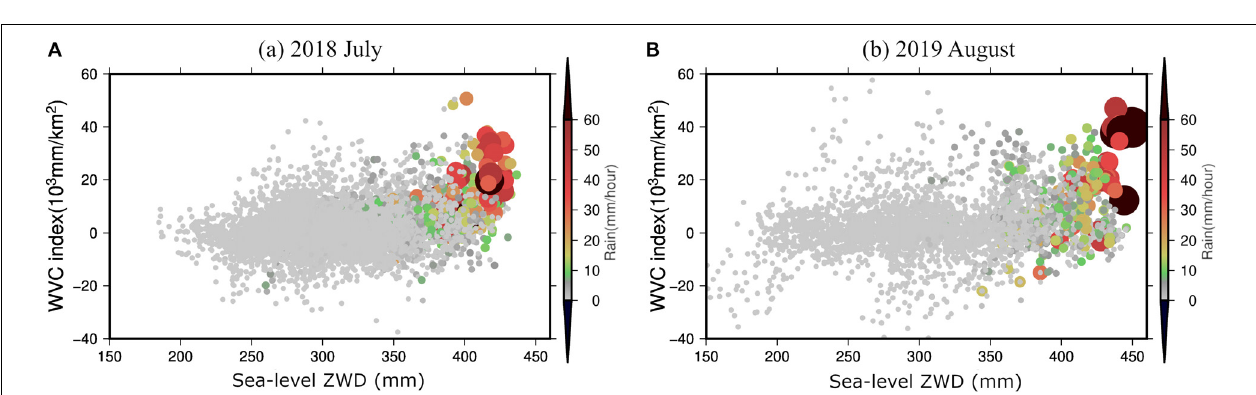
FIGURE 9 | Same as Figures 8B,C , but we stacked data for 12 and 5 AMEDAS stations showing hourly rain rate exceeding 50 mm in July 2018 (A) and August 2019 (B) , respectively. Again, we compare hourly rain rates with the WVC and ZWD, calculated at the nearest grid points of the AMEDAS stations.